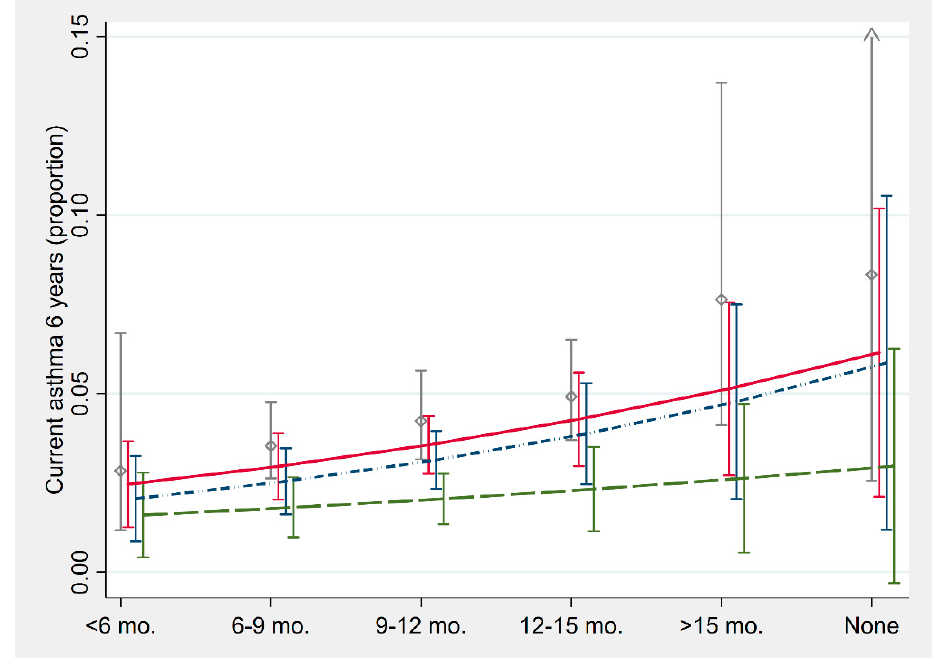
Figure 2. The proportion of children with current asthma at six years of age over the age fish was introduced into the infants’ diet. This graph presents the observed proportions (grey diamonds) and predicted proportions from adjusted logistic regression models including all participants (red solid line) and excluding infants with diagnosis or symptoms before six months (blue dashed/dotted line) and 12 months (green dashed line). Spikes indicate 95% CI. Delayed introduction of fish was associated with increased prevalence of asthma in all models, although after removing infants who had developed allergic symptoms before 12 months of age the association between age of introduction and prevalence of asthma is substantially weakened (green dashed